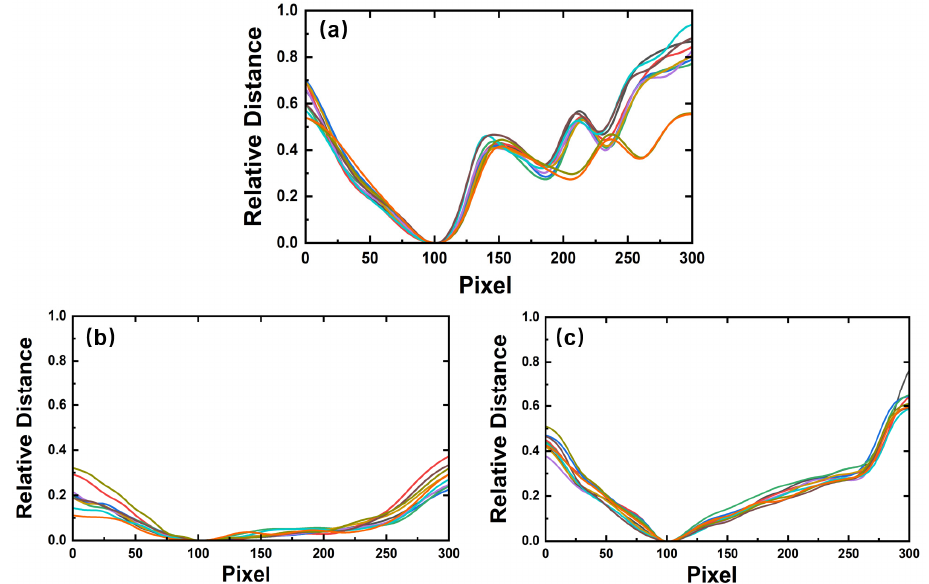
Figure 9. Normalized facial contour curves of 10 samples: ( a ) facial contours without a mask, ( b ) facial contours with a surgical mask, and ( c ) facial contours with an N95 mask.